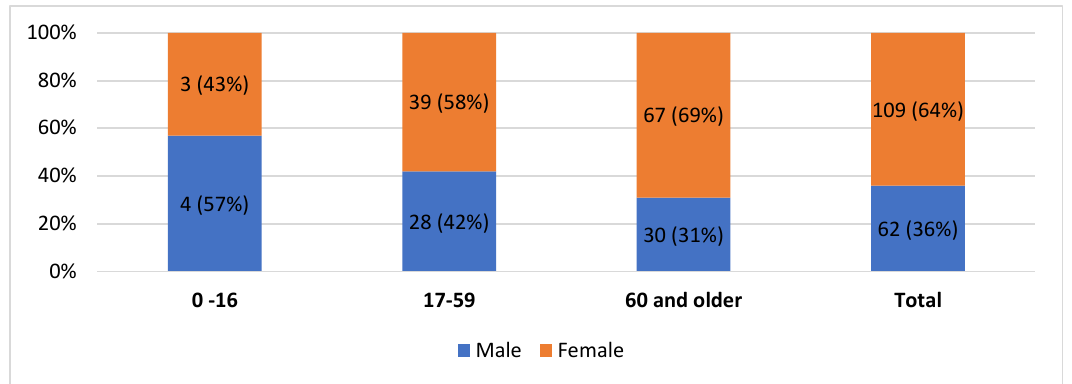
Figure 2. Analysis by age groups and gender of the patients admitted to hospital for traumatic injuries (Crater area, from 6 to 9 April).